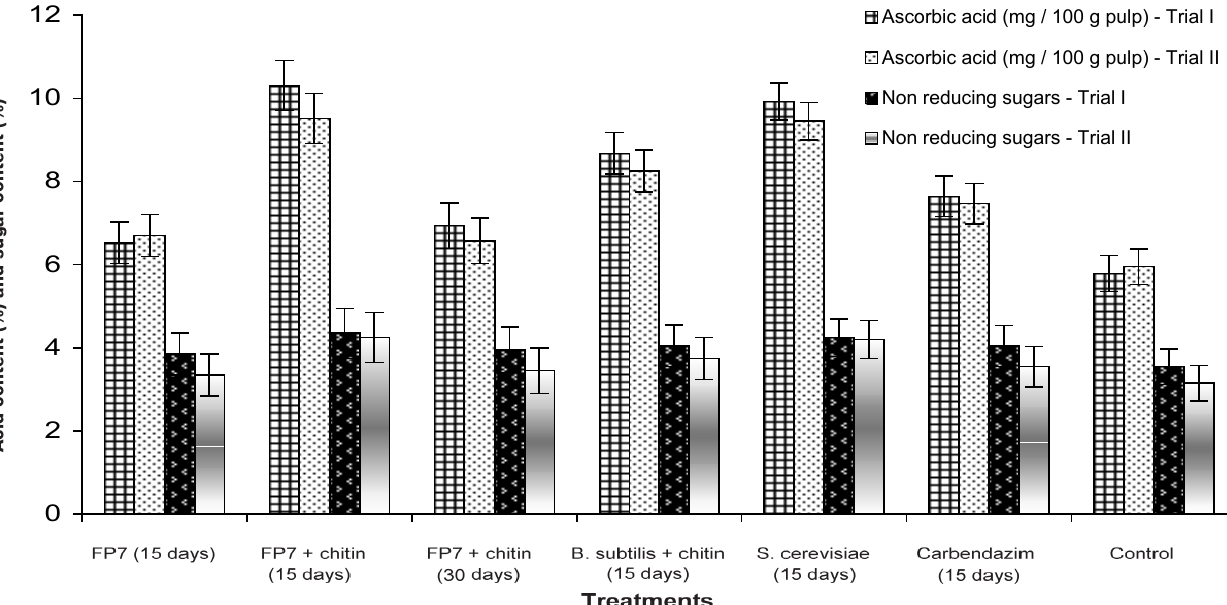
fruits.Fig. 9. Effect of pre-harvest application of biocontrol formulations on ascorbic acid and non reducing sugars content in mango